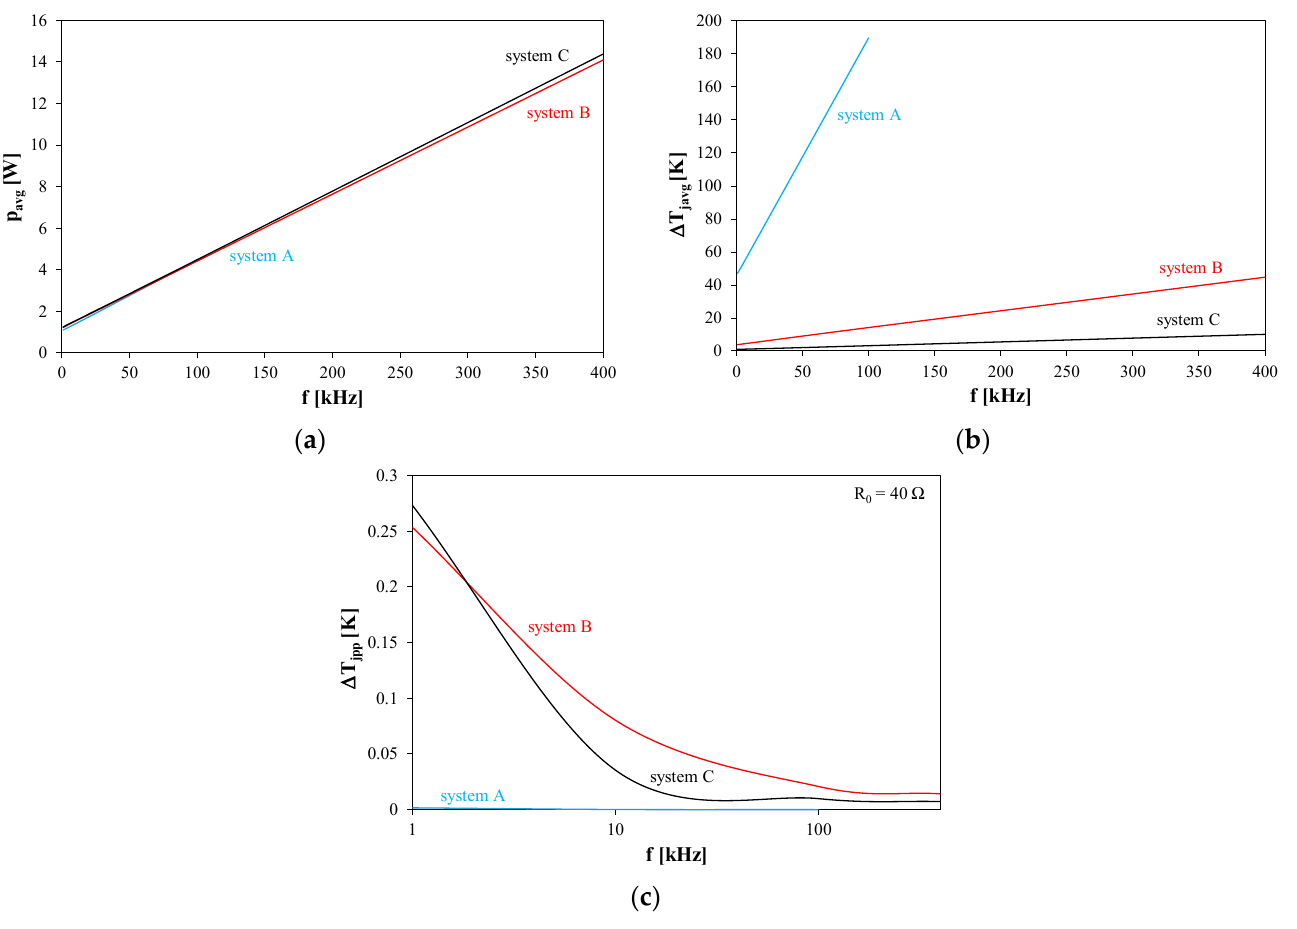
Figure 7. Dependence of the average power value ( a ), of the junction temperature excess ( b ) and the peak-to-peak value of the junction temperature ripples ( c ) on frequency for the transistor operating in the switch circuit cooperating with various cooling systems.